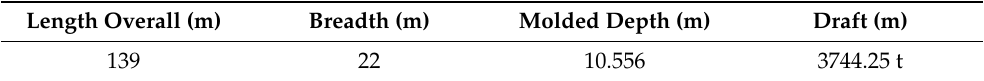
Table 1. The principal dimensions of the intact